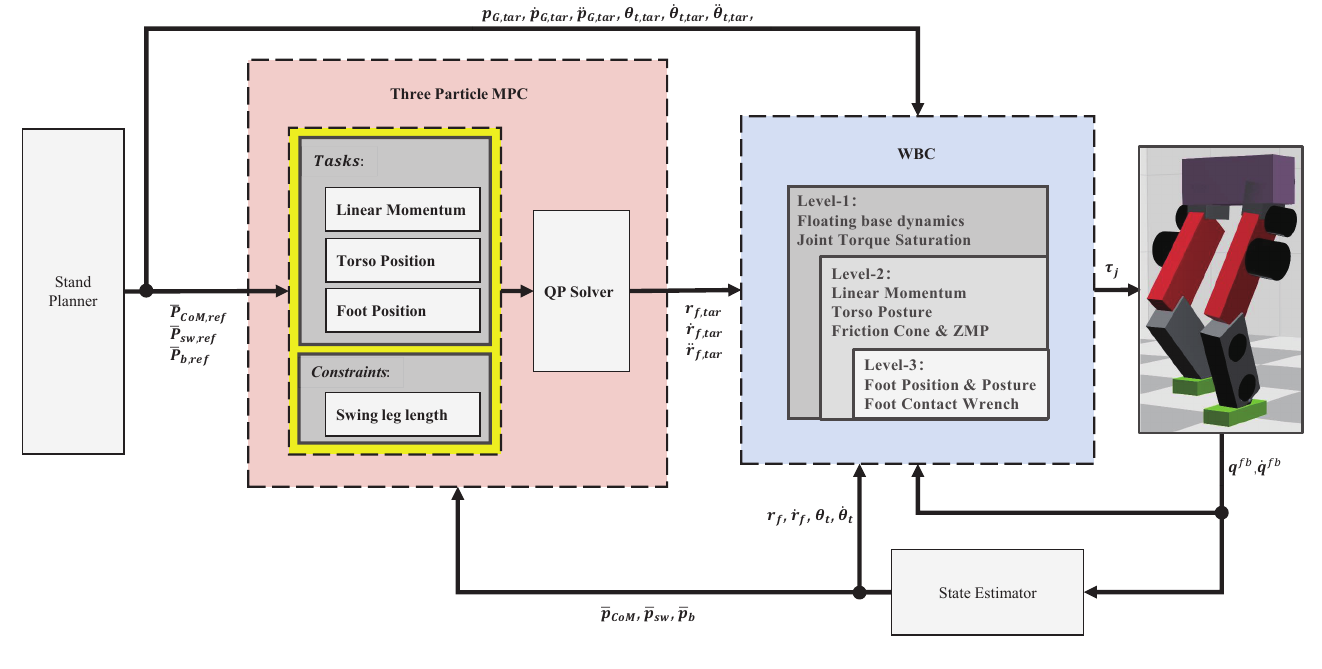
Figure 2. Overall control